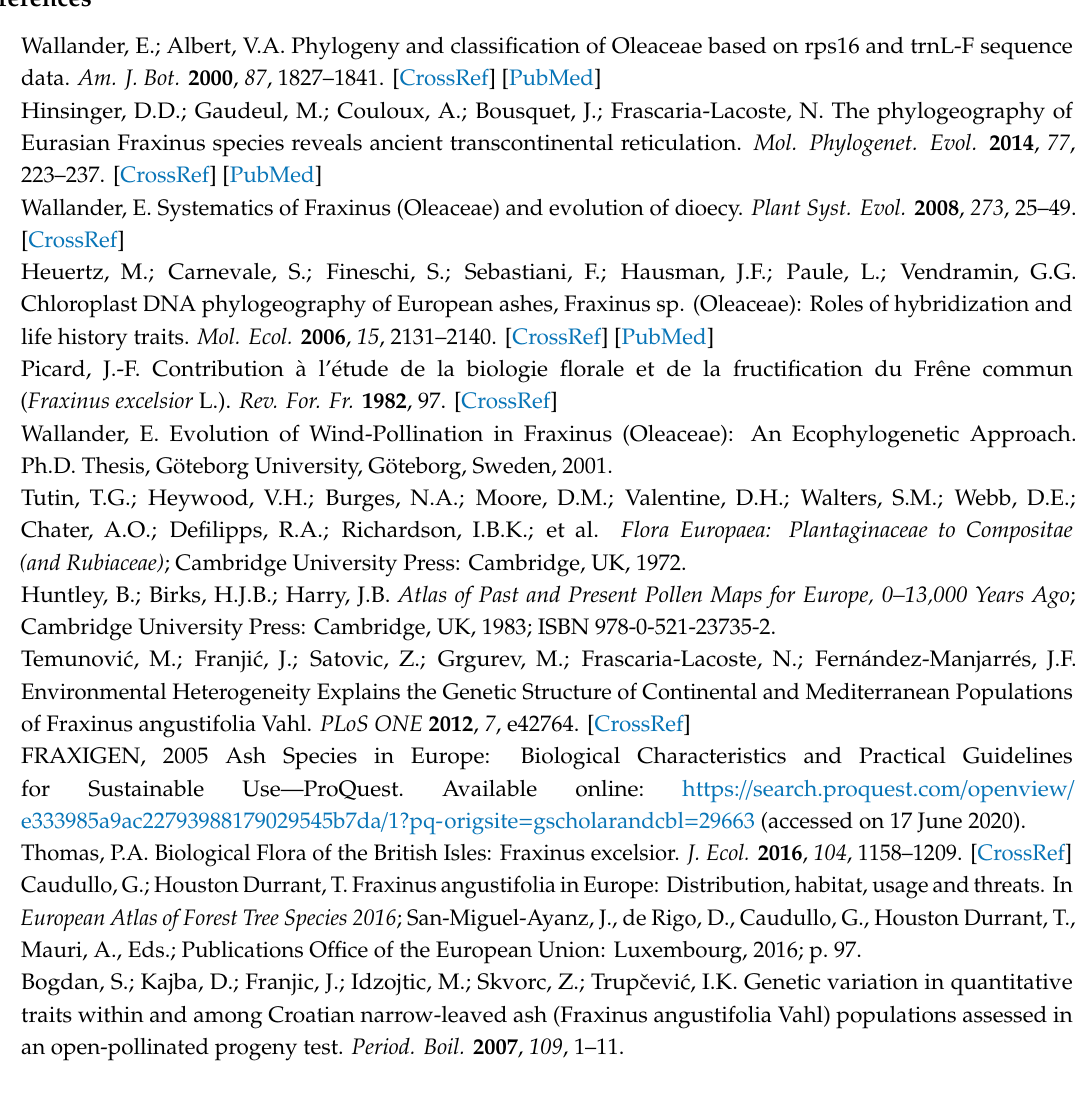
Table S1: Morphological traits of studied samples, belonging to manna ash collection and samples belonging to F. ornus , used as reference. In brackets the number of samples analyzed belonging to each local variety / species. Three replicates for each trait were analyzed. Table S2: Nuclear SSR profiles of samples belonging to (A) set #1 and (B) set #2. Table S3: Allelic richness ( AR ) evaluated for FAN accessions grouped based on sampling location. In the table geographic coordinates (Long and Lat) and AR values for each nSSR were indicated. Table S4: Pairwise population Fst values. Figure S1: Neighbor-joining (NJ) tree based on population pairwise fixation index. Genetic distances were computed among populations grouped based on country of